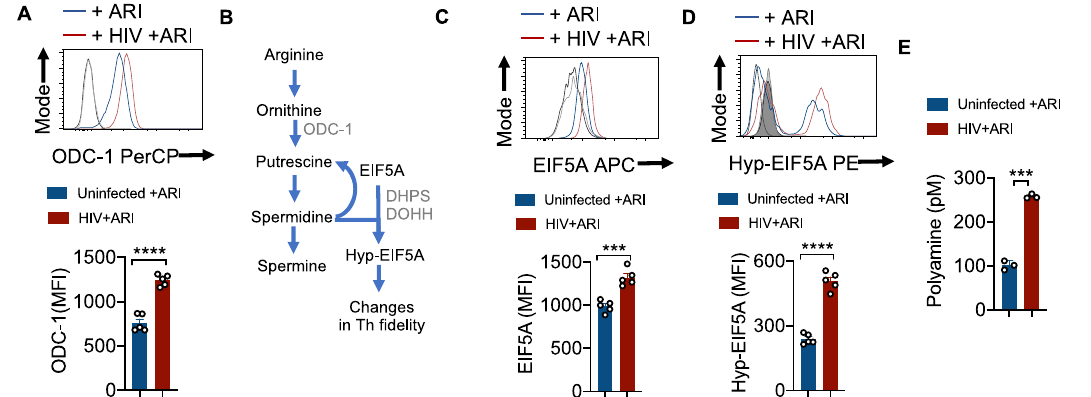
Fig. 3 | HIV-1 upregulates ODC-1, EIF5A, EIF5A hypusination and polyamine synthesis in CD4 + T cells even after ARI treatment. A HTOC were TCR-activated and infected with HIV. ARI was added the next day to block subsequent rounds of infection.CellswereallowedtoexpandinthepresenceofTGF- β 1(10ng/ml)andIL- 2 (100U/ml) and ARI for 6 days as described in methods ( n =5 independent experiments). Representative fl ow cytometric data showing ODC-1 expression in CD3 + CD8negativecells(CD4+Tcells)(top)andstatisticalanalysesofMFIfrom fi ve independent experiments (bottom) are shown. B Key intermediate steps in poly- aminesynthesis.Cellswerestimulatedandprocessedfor fl owcytometryasin A for